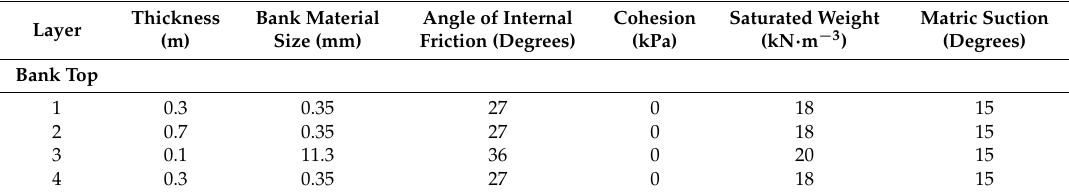
Table 4. Summary of input values used for the surveyed bank profile to calculate factor of safety in bank model BSTEM 5.2.